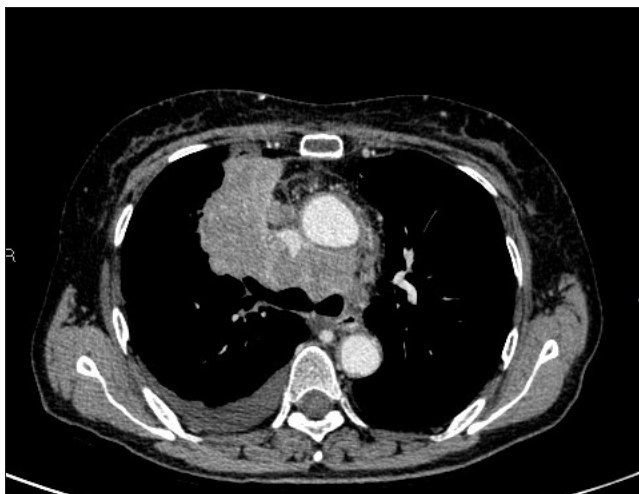
Figure 2. CT of the thorax: Extensive, irregular, non-homogenous consolidation in the right upper lobe